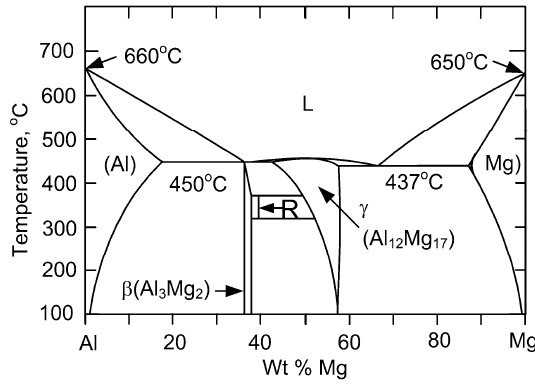
Figure 1. The Al-Mg phase diagram [20].